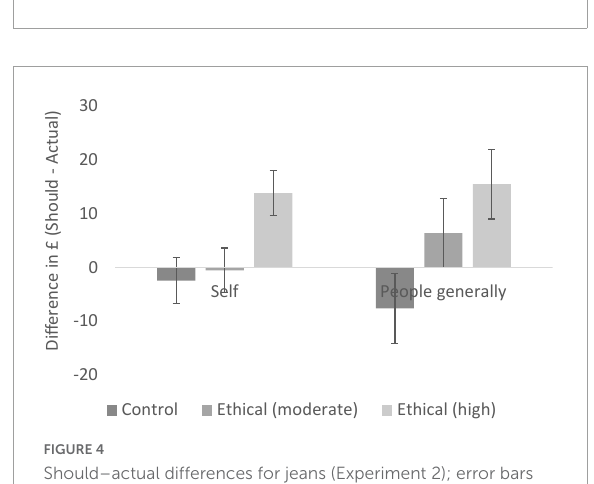
FIGURE3 Reported should and actual spends for clothing in the two control conditions (Experiment 2); error bars show 95% confidence intervals.